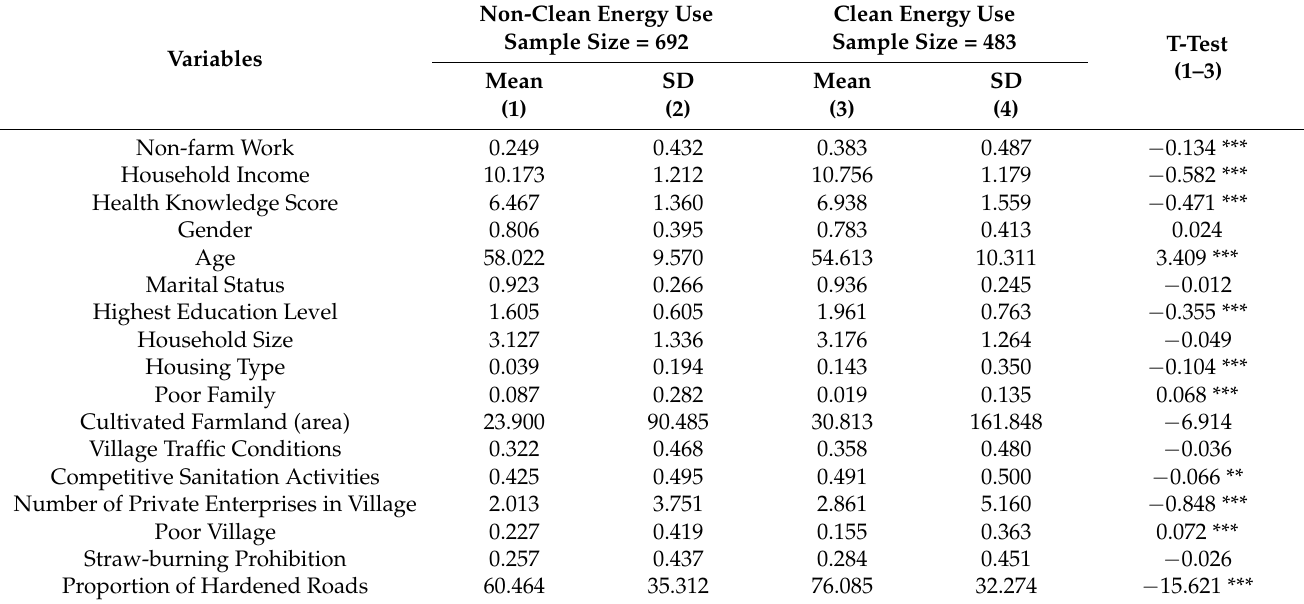
Figure 2. Non-clean energy use in the survey area. Table 1. T-test Results between Respondents Who Use Clean Energy vs. Non-clean